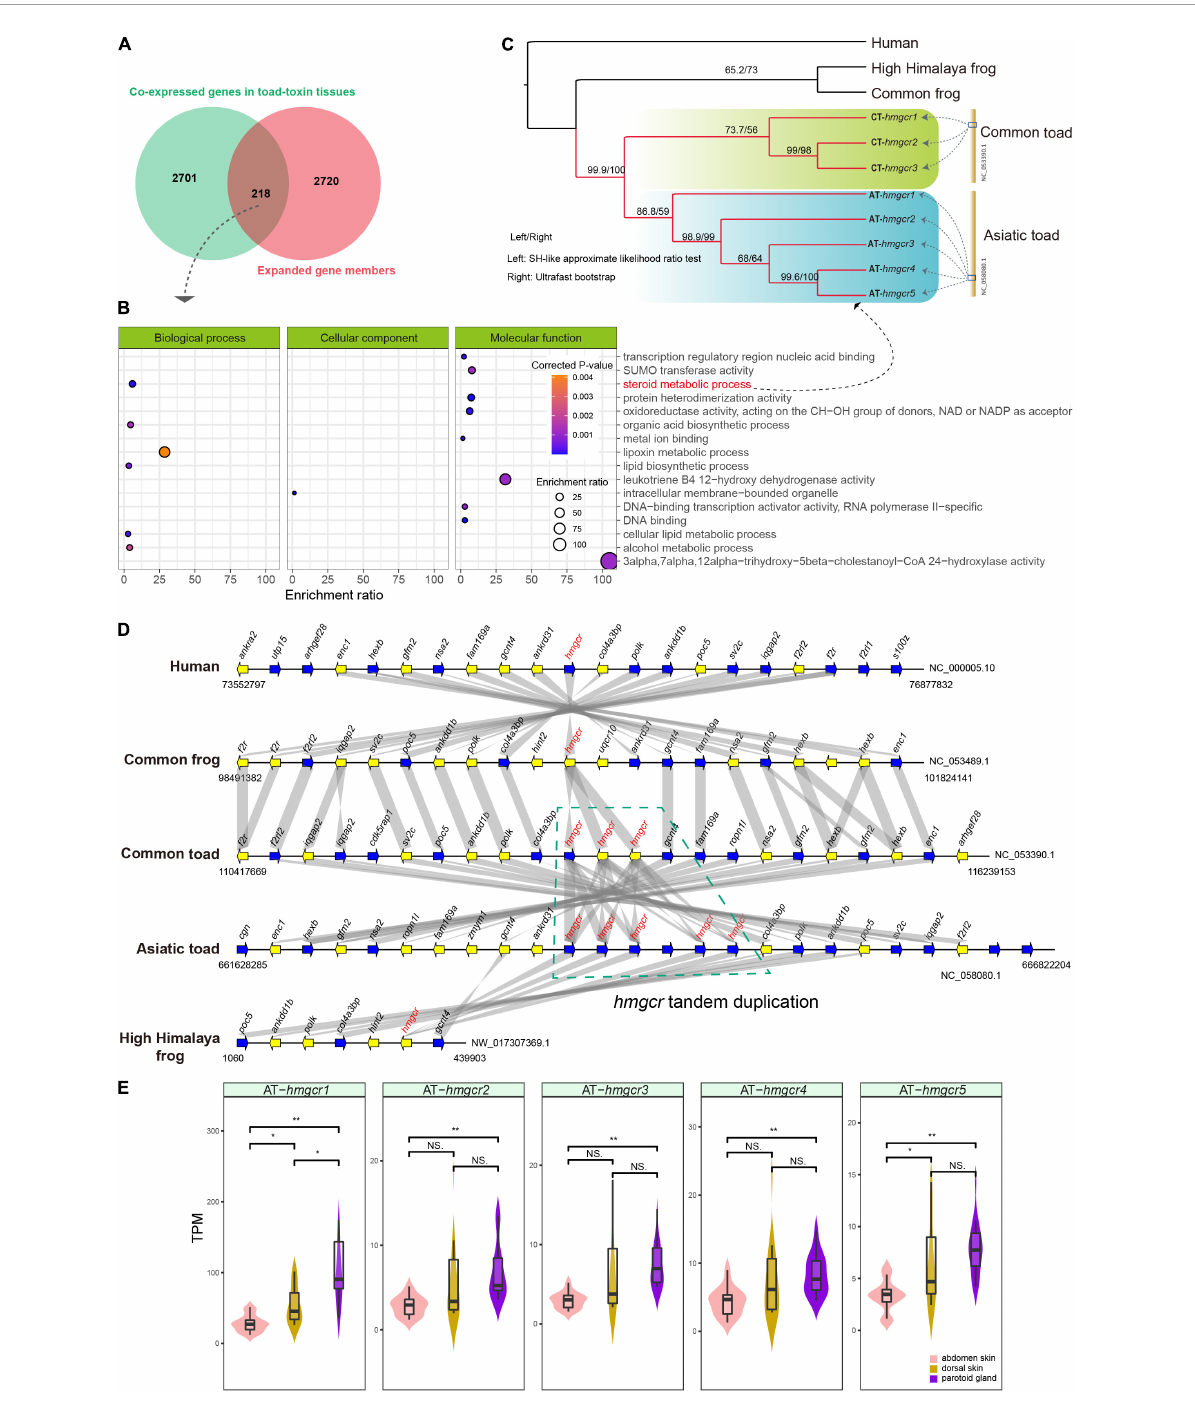
FIGURE4 Overlapping of co-expressed genes in toad toxin producing tissues and expanded gene members. (A) The 218 overlapped genes. (B) Gene Ontology (GO) enrichment of the overlapped genes. (C) The phylogeny of multiple hmgcr copies within the GO terms of steroid metabolic process among Asiatic toad (five copies including AT- hmgcr1 , AT- hmgcr2 , AT- hmgcr3 , AT- hmgcr4 and AT- hmgcr5 ), common toad (three copies including CT- hmcgr1 , CT- hmcgr2 and CT- hmcgr3 ), common frog, high Himalaya frog, and human. (D) Landscape of hmgcr copies and their neighbor genes among the five examined species. Gene syntenic relationships were represented by the gray bands; the green polygon means the tandem duplicates within the two toads, whereas other species have only one hmcgr copy. (E) Transcriptional comparisons of the five hmgcr copies among abdomen skin, dorsal skin and parotoid glands of Asiatic toad based on a student t -test. “*” and “**” represent the significant levels less than 0.05 and 0.01, respectively. “NS” stands for “no significant